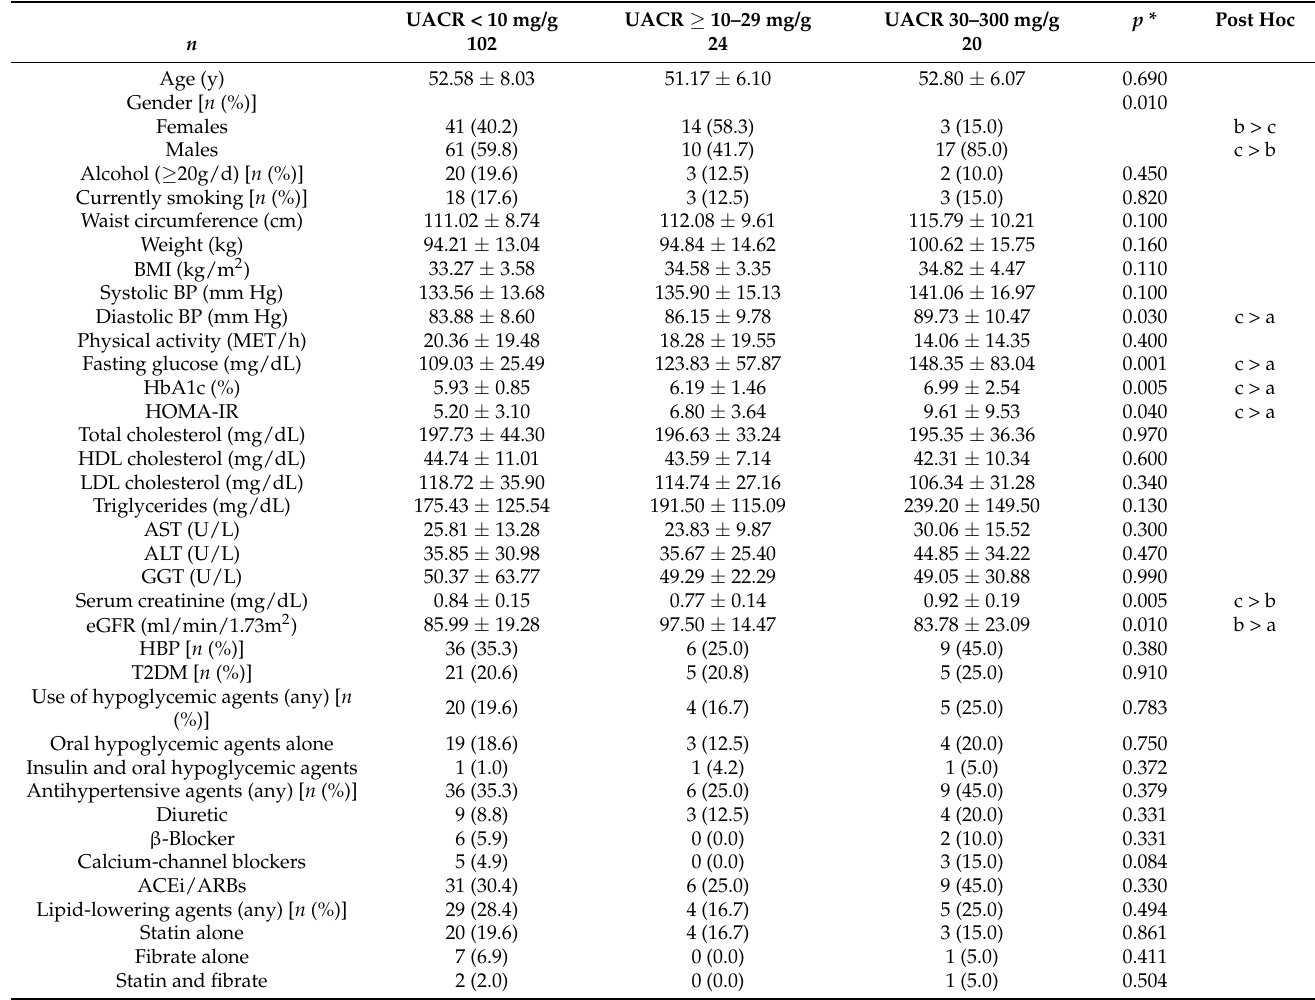
Characteristics of the study cohort as stratified by UACR status are displayed in Table 1. As compared to patients with normal levels of albuminuria, patients with UACR 30–300 mg/g presented a higher diastolic BP, and higher levels of fasting glucose, HbA1c, and HOMA-IR than patients with normal albuminuria. They were also more likely to be male and present higher serum creatine levels than patient with mildly increased albuminuria. Finally, patients with mildly increased albuminuria presented a higher eGFR than those with normal albuminuria. There were no significant differences across UACR status for age, smoking status, alcohol consumption, waist and hip circumferences, body weight, BMI, systolic BP, heart rate, total-cholesterol, HDL-C and LDL-C, TG, prevalence of T2DM, high BP, physical activity levels (expressed as MET/h), and use of medications. Table 1. Differences in patients’ characteristics across stages of UACR. UACR < 10 mg/g UACR ≥ 10–29 mg/g UACR 30–300